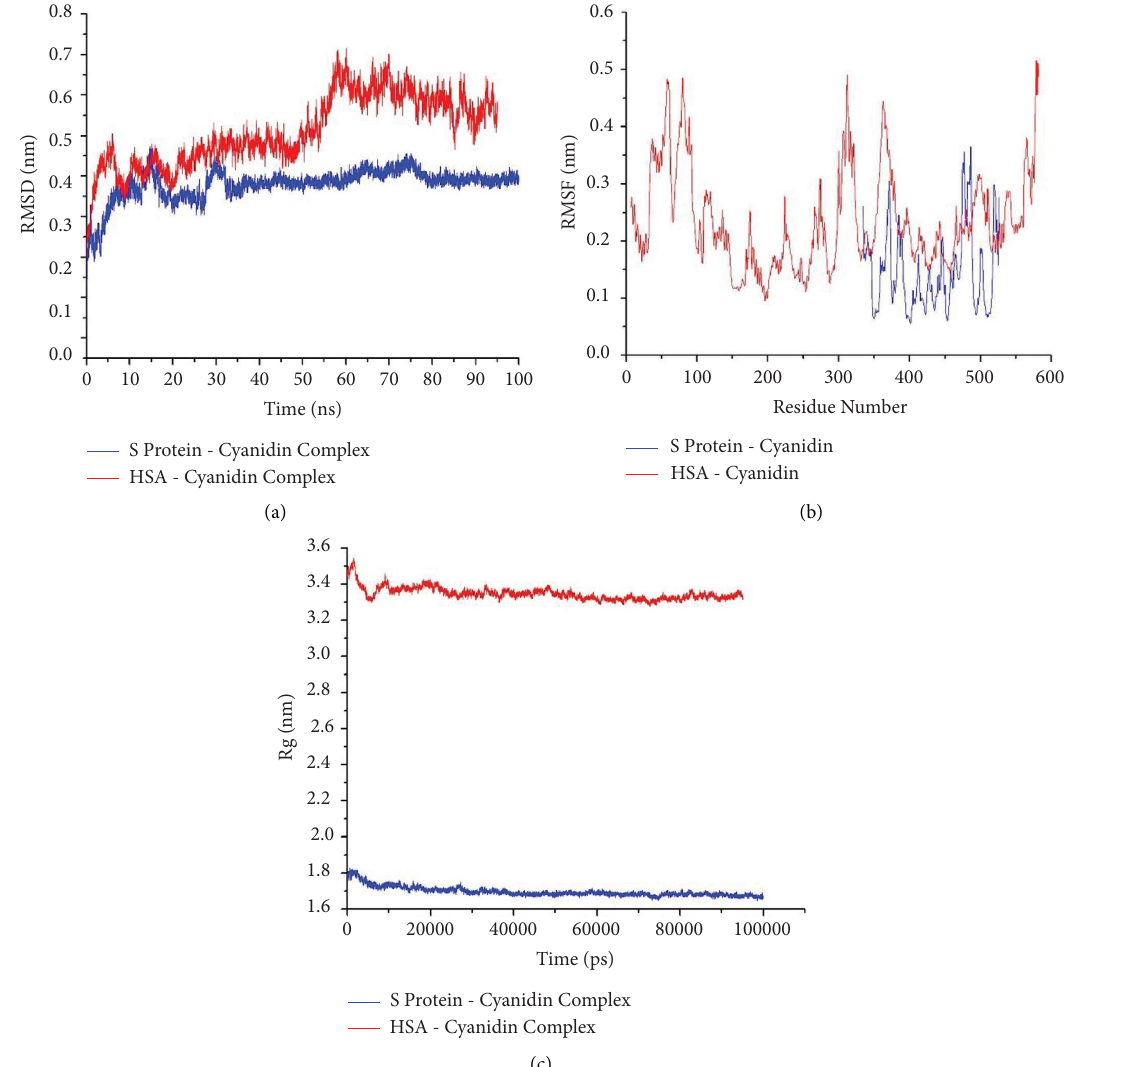
Figure 4: (a) Plot of RMSD, (b) RMSF, and (c) Rg during 100ns MD simulation of spike protein-cyanidin complex and HSA-cyanidin